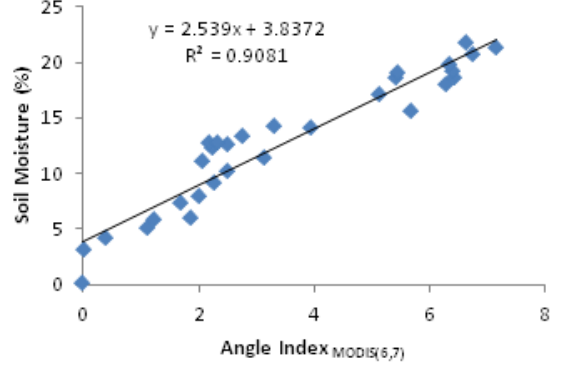
Fig. 13 Relationship between angle index bands 6 and 7 MODIS and soil moisture